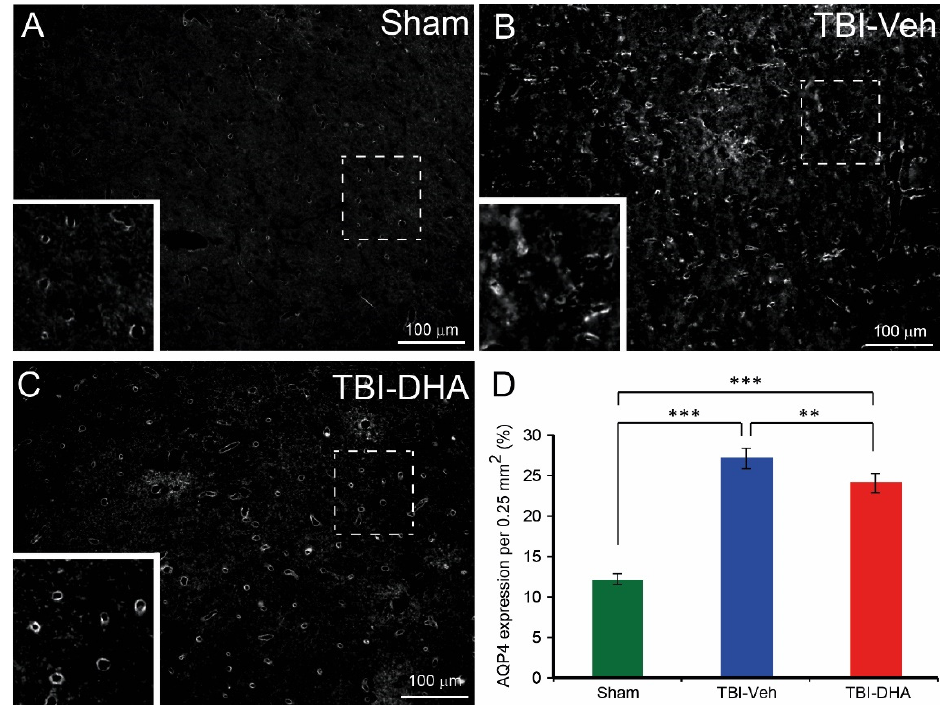
Figure 5. DHA-treated TBI rats exhibited less aquaporin 4 (AQP4) expression at the peri-injury site than the vehicle-treated TBI rats at 7 days post injury. ( A ) In sham-operated rats, some visible AQP4 expression was observed within the blood vessels. ( B ) Vehicle-treated TBI rats exhibited lots of AQP4 expression within and around blood vessels. ( C ) DHA-treated TBI rats exhibited some AQP4 expression within blood vessels. ( D ) Analysis of AQP4 expression at the pericontusional site revealed a significantly reduced loss of AQP4 expression in blood vessels in DHA-treated rats (red, n = 6) compared vehicle-treated TBI rats (blue, n = 6) at 7 days post injury. AQP4 expression in sham-operated rats (green, n = 4) was significantly lower than TBI rats. The ** and *** indicate p < 0.01 and p < 0.001, respectively.